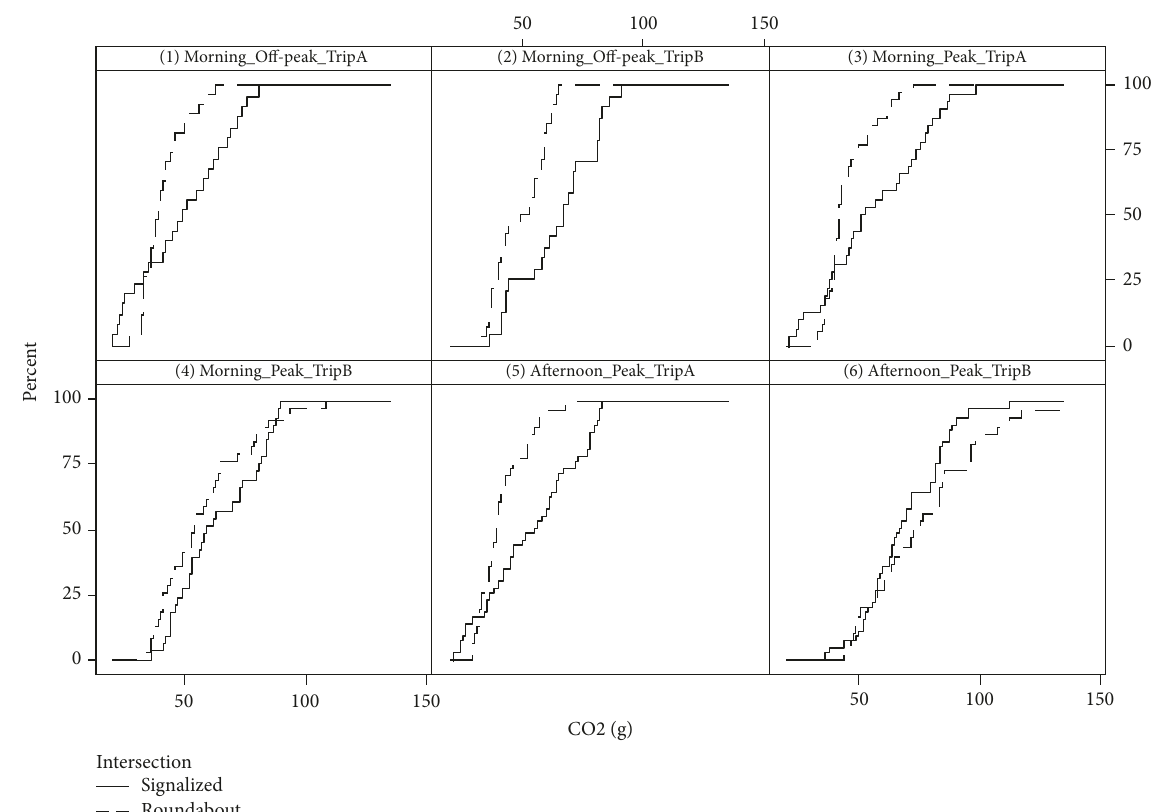
Figure 2: Empirical Cumulative Distribution Functions of CO 2 emissions (g) by intersection type and trip conditions.